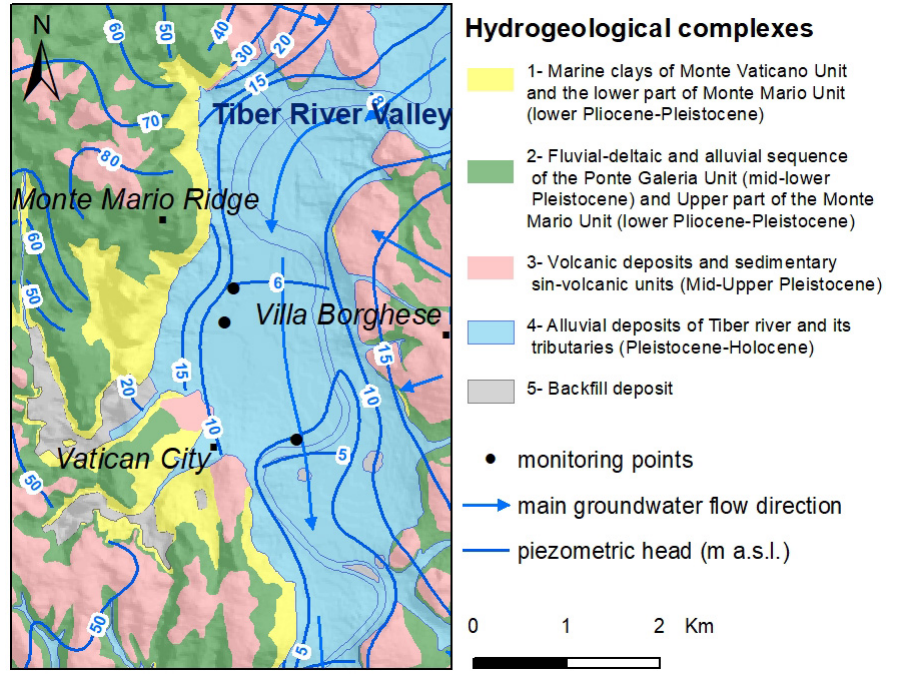
Figure 3. Hydrogeological complexes in the study area. The boreholes S2 and S3 are equipped with piezometers for groundwater monitoring.